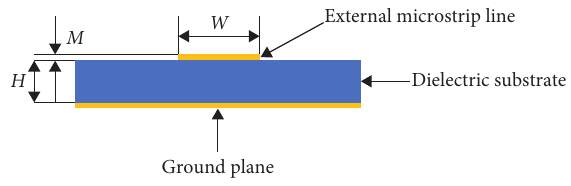
Figure 8: The cross-section structure of PCB.